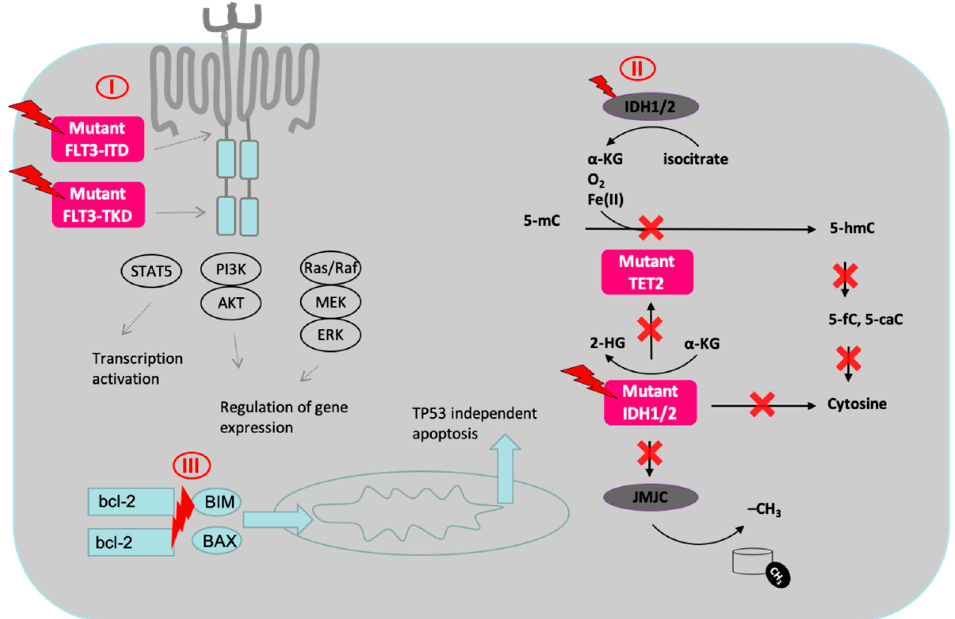
Figure 2. Cellular localization and mechanism of action of drugs targeting specific mutations. I. Targeting mutant FLT3 with TKI-inhibitors including midostaurin, quizartinib, crenolanib, gilteritinib and lestaurtinib. Mutations in FLT3 are present in approx. 30% of AML patients. II. Targting mutant IDH1 and IDH2 with IDH1 and IDH2 inhibitors including enasidenib and ivosidenib. Mutations in IDH are present in approx. in 30% of elderly AML patients. Both TET2 loss-of-function and IDH1/2 gain-of-function mutations result in reduced 5-hmC levels and in global promoter (and histone) hypermethylation. III. Targeting Bcl-2: Venetoclax binds to Bcl-2 thereby causing translocation